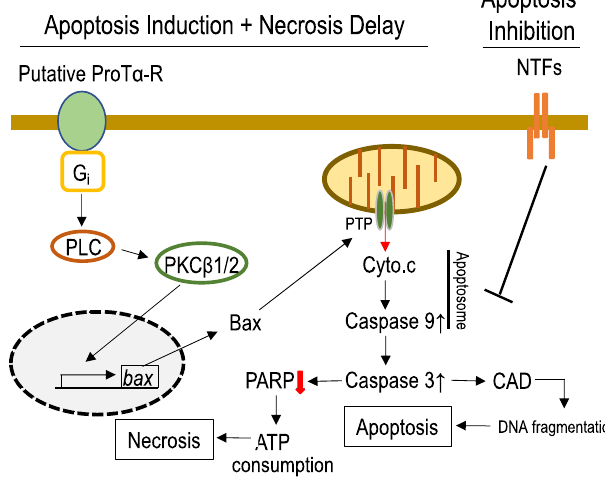
Figure 2. Proposed mechanisms underlying ProT α‐ induced apoptosis induction. ProT α activates PKC ‐β 1 and β 2 through a stimulation of the putative G i ‐ coupled receptor and phospholipase